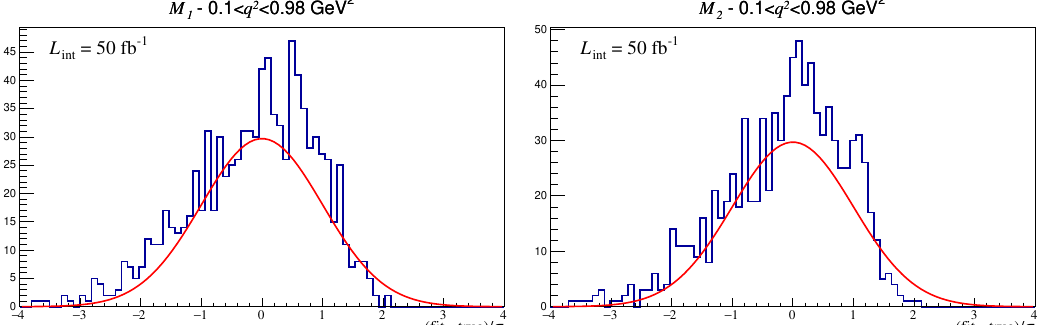
Figure 15 . The pull distributions for the optimised P-wave observables (left) M 1 and (right) M 2 from pseudoexperiments with the expected LHCb Upgrade I yield from 50 fb − 1 integrated luminosity. The overlaid red curve is a reference of the ideal distribution for the pulls, a Gaussian function with σ = 1 .